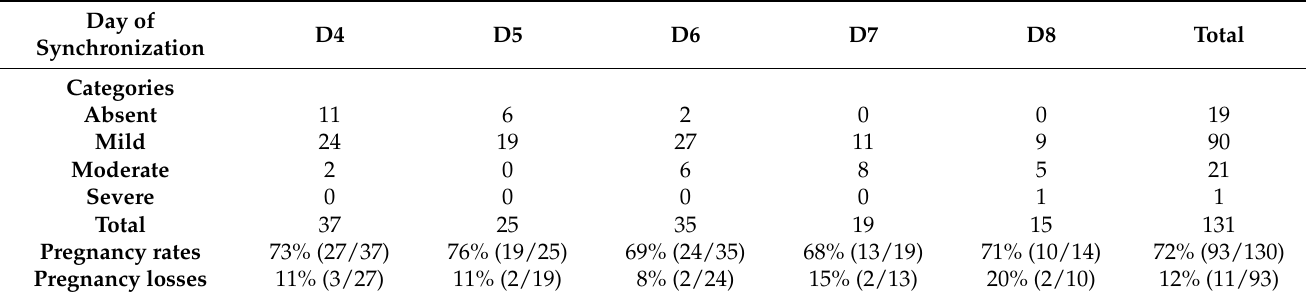
Figure 6. Serum progesterone concentrations in acyclic mares (n = 12) treated with intravaginal progesterone-releasing device (IPRD). ( A ) Mares were treated with estradiol-17 β for 3 days and then given an IPRD (D0). The IPRD was removed nine days later (D9). ( B ) Mares were resynchronized three days after removal of IPRD after the first synchronization. Mares were again treated with estradiol-17 β for 3 days and then had a new IPRD inserted (R0). The IPRD was kept for three days (R3). D, day after treatment with IPRD; R, day after resynchronization with IPRD. Different superscripts ( a,b ) denote effect of days ( p < 0.05). Table 1. Vaginal discharge, pregnancy rates, and losses of embryo recipient mares synchronized with an intravaginal progesterone-releasing device at D4 to